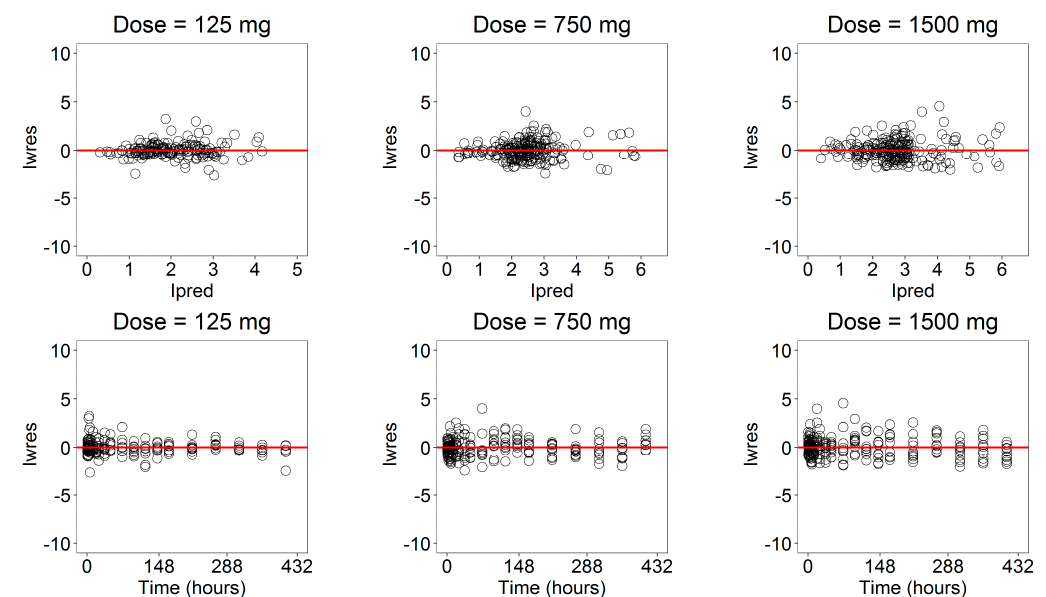
Figure A3. Weighted residuals for the serum concentration of progesterone plotted against time ( upper panels ) and individual prediction ( lower panels ) stratified on the dose levels.